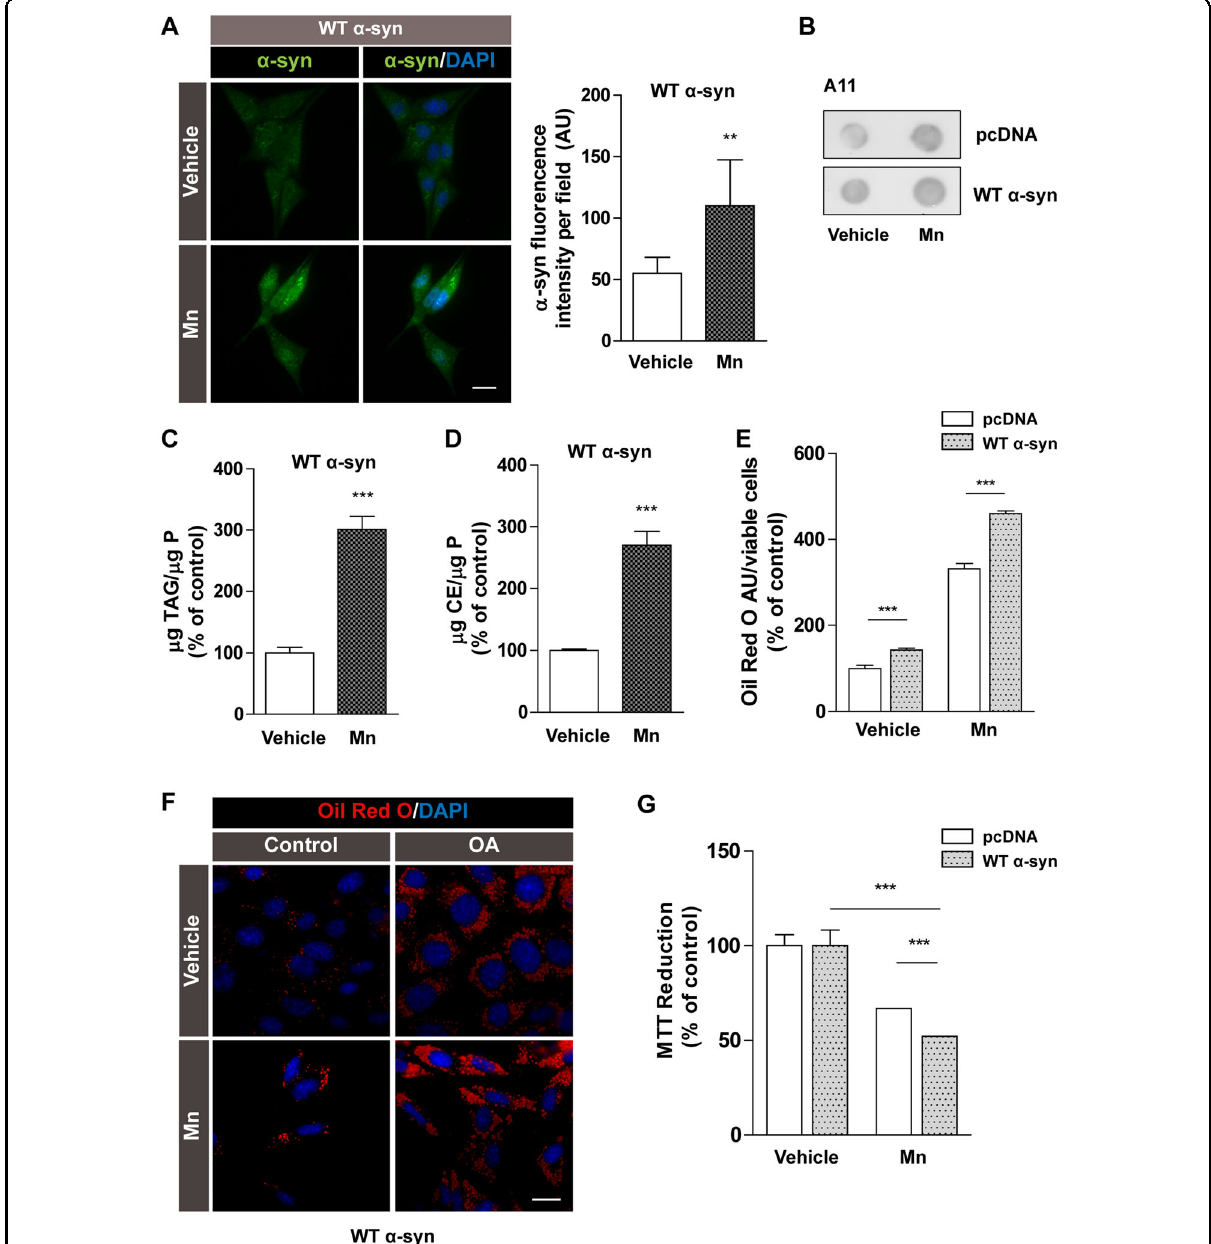
Fig. 7 The presence of Mn rendered WT α -syn cells more sensitive, affecting cell viability. A Increased α -syn levels in WT α -syn exposed to Mn were detected by immunocytochemistry. DAPI was used as nuclear marker. B The enhancement of α -syn aggregation under Mn exposure was determined by Dot blot using A11 antibody. C , D TAG and CE content during Mn treatment was analyzed through detection kits in WT α -syn cells. E , F LD accumulation during Mn exposure was assessed trough Oil Red O staining. DAPI was used as nuclear marker. G The MTT reduction assay was used to evaluate the effect of Mn treatment on cell viability. A – G Scale bars 20 µm. All experiments were repeated three times. Bars represent means ± standard deviation (SD, n = 3). *** p < 0.001 vs